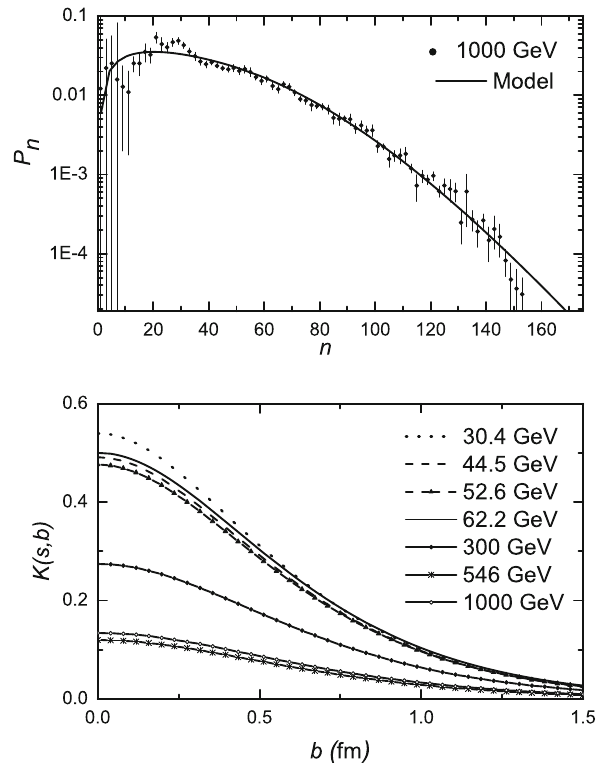
Fig. 7 Same as Fig. 1 but at 1000 GeV. Data points from [16]